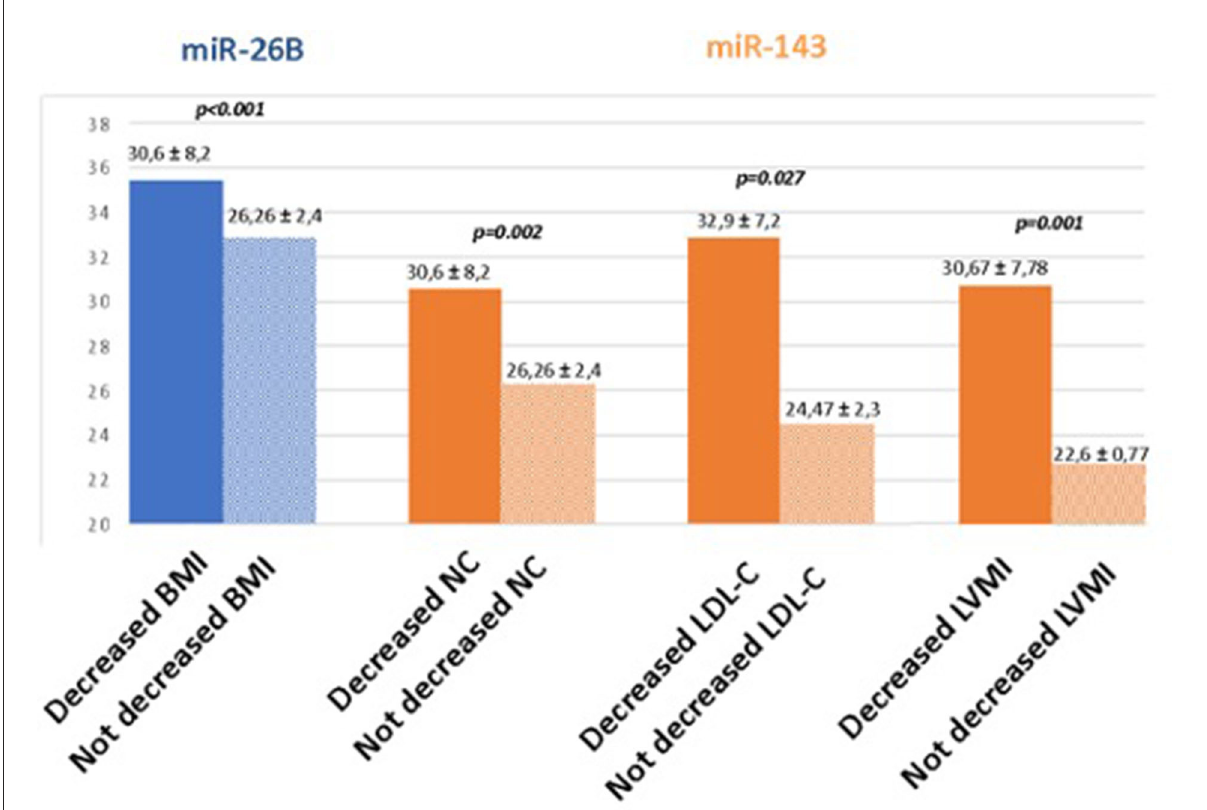
FIGURE2 Comparison between the quantitative expression of surrounding adrenal neoplasia AT miRNAs and follow-up data. BMI, body mass index; NC, neck circumference; LDL-C, LDL cholesterol; LVMI, left ventricular mass indexed for the surface body area.